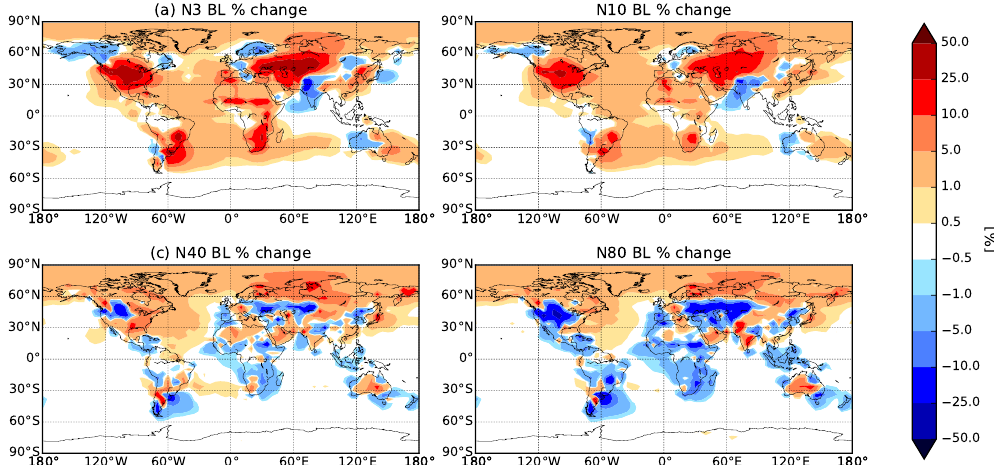
Figure 9. Percentage change in annually averaged boundary layer (a) N3, (b) N10, (c) N40, and (d) N80 when changing LPJ-GUESS BVOC emissions from year 1000 to year 2000 with anthropogenic emissions off (BE2.AEO.LPJ–BE1.AEO.LPJ). Globally averaged, N3 and N10 increased by 5.9 and 3.5%, respectively, whereas N40 and N80 decreased by 0.1 and 1.8%, respectively (see Table 2). An increase in particle number concentration is represented in red, and a decrease in